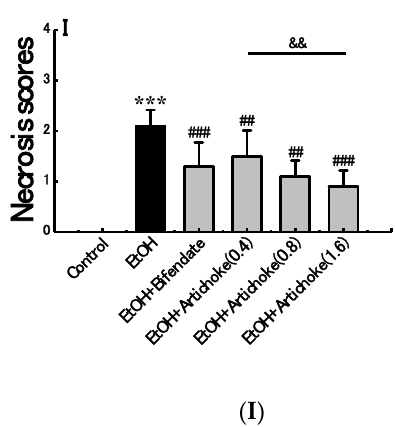
Figure 2. Effect of artichoke on alcohol ‐ induced histopathological changes in liver tissues. ( A ) Control group, ( B ) EtOH group, ( C ) positive control group, ( D ) low ‐ dose group, ( E ) middle ‐ dose group, ( F ) high ‐ dose group, ( G ) steatosis scores, ( H ) inflammation scores, ( I ) necrosis scores, and central vein (CV). Hematoxylin and eosin staining. Original magnification, 200×. Values represent means ± SD ( n = 10); *** p < 0.001 vs. the control group; ## p < 0.01, ### p < 0.001 vs. the EtOH group; && p < 0.01, &&& p < 0.001.